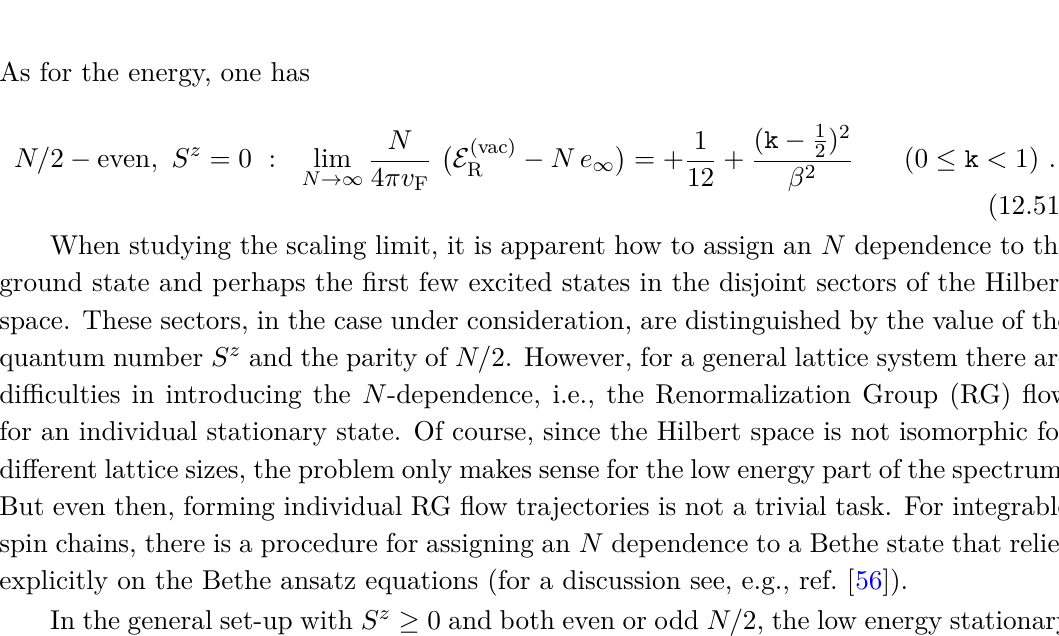
Figure 3 . The left panel shows the typical pattern of Bethe roots in the complex θ plane (cid:1) − 1 log( ζ ) for the ground state of H with N/ 2 odd and S z = 0 , which flows to ¯ e 0 , 0 2 (cid:0) (cid:1) e ( − ) P (vac) . Note that the right most root, located far above the real axis, has = m ( θ ) = π 2 , 0 NS right panel presents numerical data for h ( N, reg) obtained from the solution of the Bethe ansatz equations, while the solid blue line represents the fit − 1 . 3582 − 0 . 12659 /N 2 . Formula (12.38) relates the limiting value lim N →∞ h ( N, reg) of the first non-local IM corresponding to the state e ( − ) in analytical form. A numerical integration of the ODE (7.7) corresponding to e ( − ) prediction h ( ∞ ) = − 1 . 35817 , which is depicted by the black dashed line. The parameters were set 1 to be β 2 = 0 . 43 , k = 0 . 1 and $ = 1 . 3